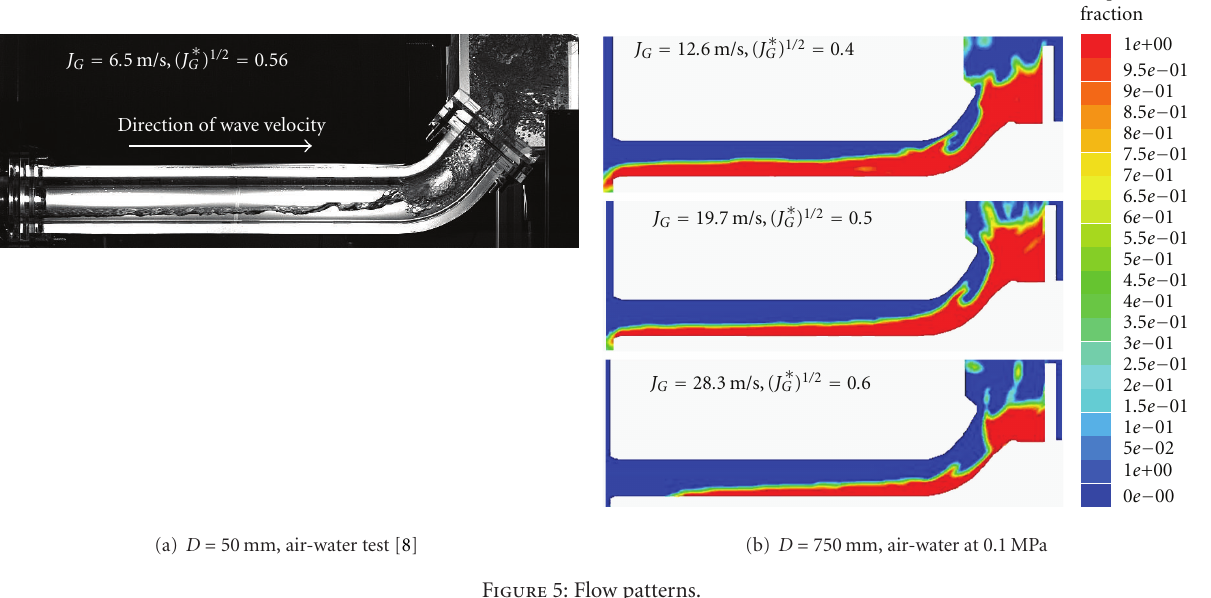
Figure 5: Flow patterns.